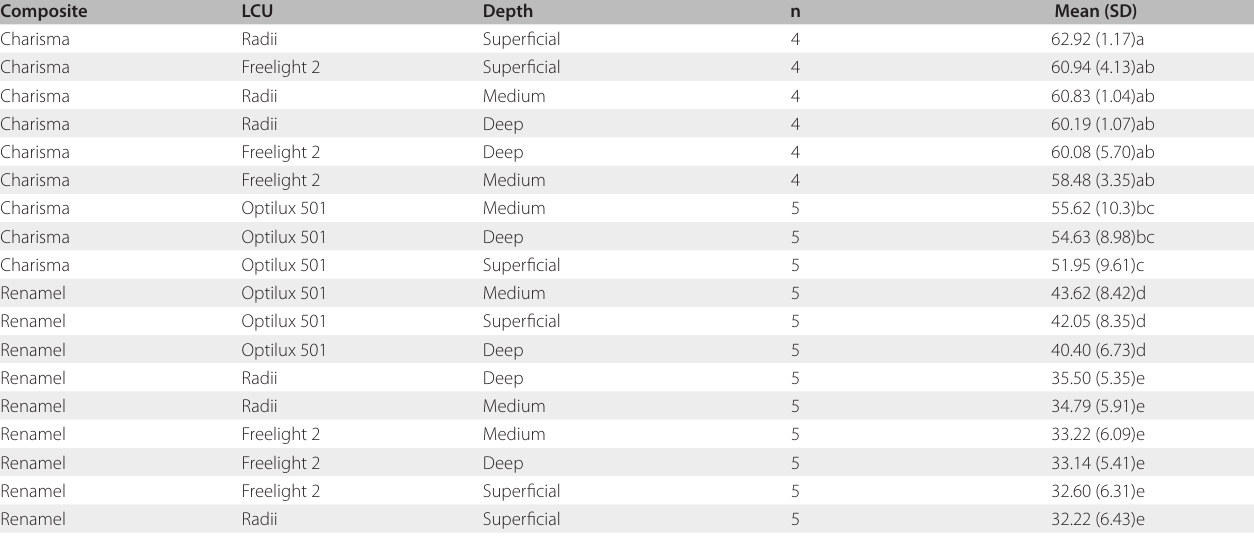
LCU: light-curing unit; different letters indicate statistically significant difference at